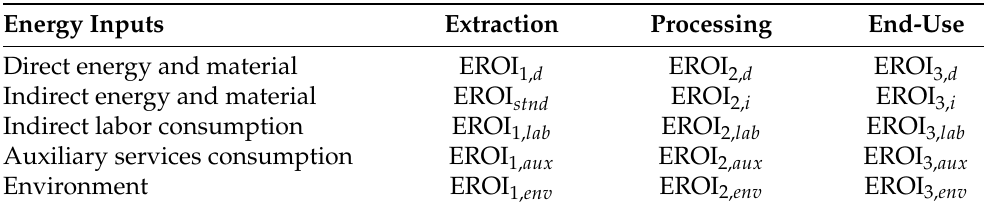
Table 1. Two-dimensional EROI nomenclature: boundaries for energy inputs and outputs. Source: Murphy et al.